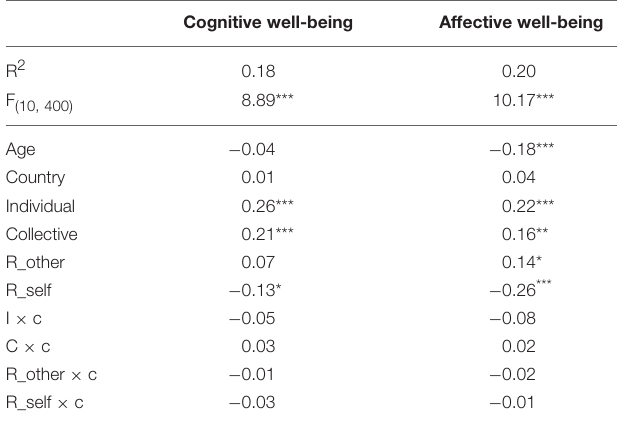
TABLE 3 | Standardized regression coefficients for four selves, and their interaction terms with culture in multiple regression analyses to predict cognitive well-being and affective